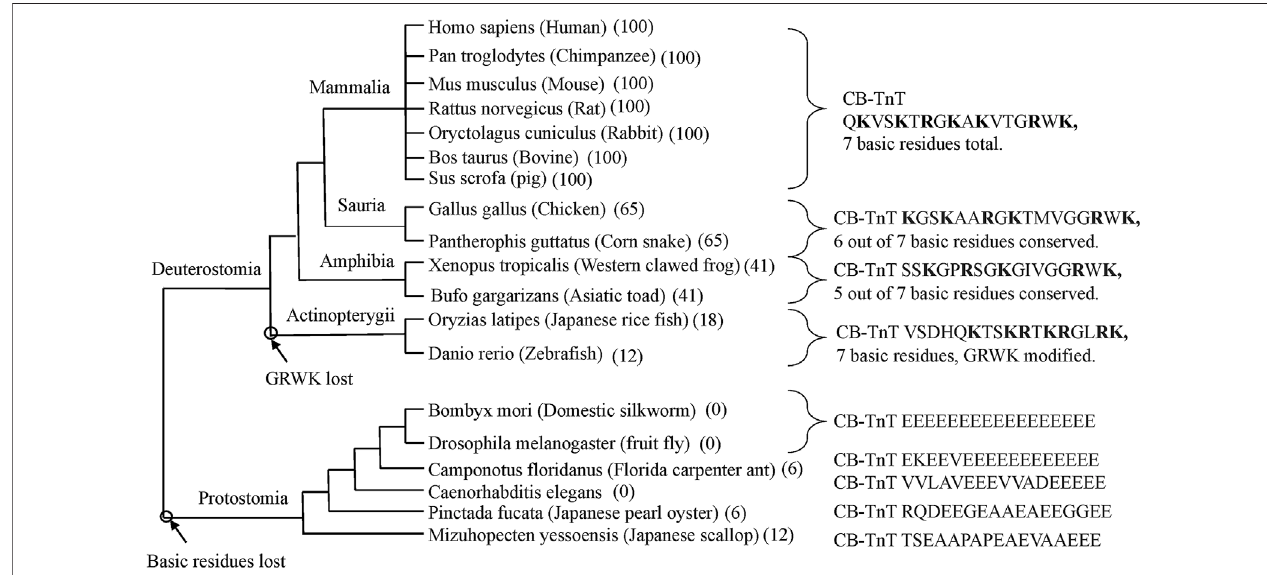
FIGURE2| Cladogramofthelast 17residues ofcardiac TnT. Themammalian sequences areallidentical.Theycontainsevenbasicresidueswithinthis17residue stretch and have a terminal GRWK. Sauria have 65% sequence conservation with 6 basic residues and a terminal GRWK. Amphibia are 41% conserved with fi ve basic residues and a terminal GRWK. Actinopterygii have 18%sequence conservation but have seven basicresidues with the terminal sequence GLRK. Protostomia lack the C-terminal basic region altogether. Note that the Protostomia have the same type of TnT in all striated muscles.